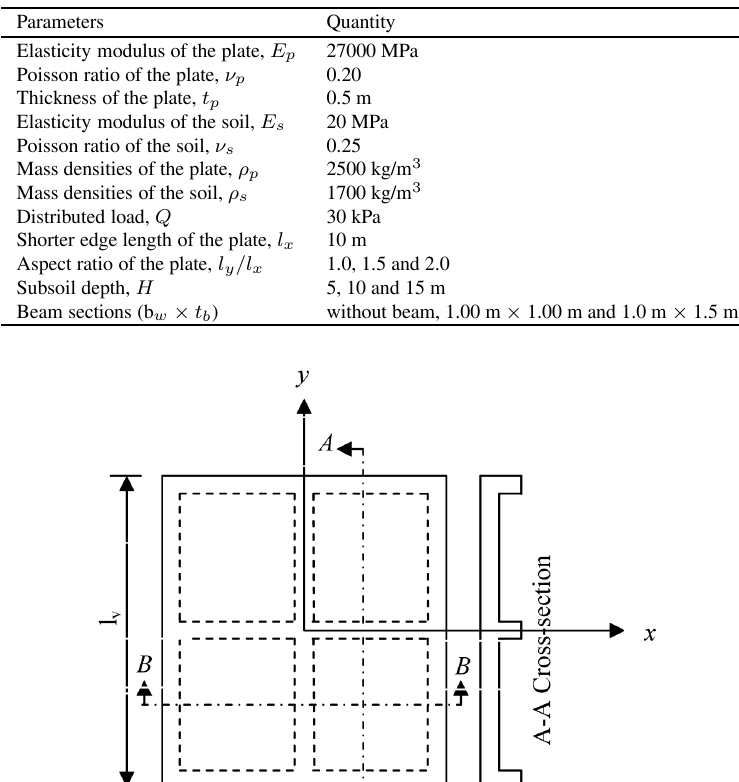
Table 1 Properties of plate-soil system used in this study